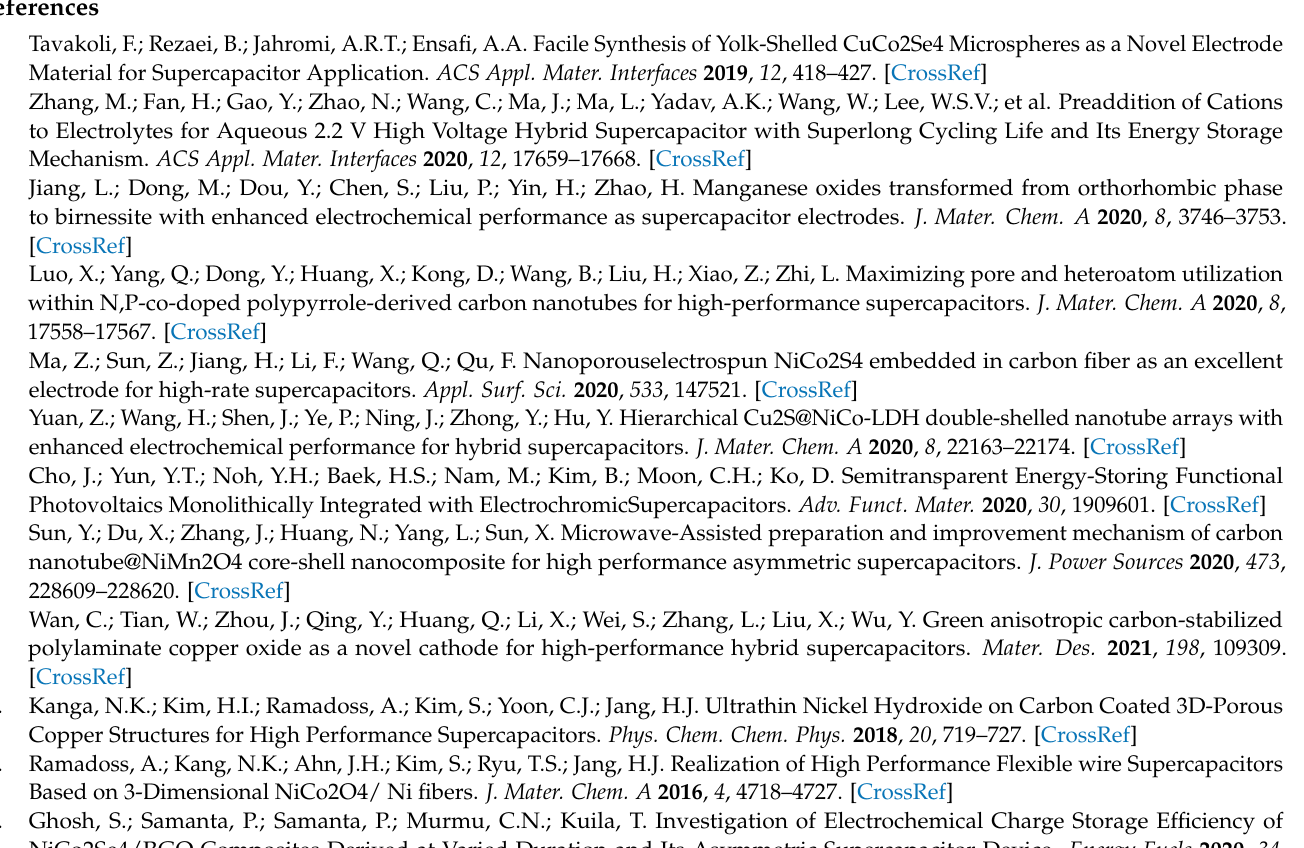
Figure S2: (a,b) IFFT pattern of (A)and (B)regions, respectively of Figure 2a. Figure S3: FTIR spectra of NSC, NCuSC, and NCoSC electrodes. Figure S4: (a,b) CV curves of NSC and NCuSC electrodes at different scan rates, respectively. (c) Comparable discharge plots of NSC, NCuSC and NCoSC electrodes at 3 A g − 1 current density (d,e) GCD plots of NSC and NCuSC electrodes, respectively at different current density. Figure S5: (a–c) Z-View fitted EIS spectra of NSC, NCuSC, and NCoSC electrodes and (d) EIS spectra of NSC, NCuSC, and NCoSC at high frequency range. Figure S6: (a,b) CV and GCD plots of TRGO at different scan rates and current densities, respectively. (c) CV curves of positive, negative, and fabricated device in their respective potential window at constant 30 mV s − 1 scan rate. Table S1: Comparison of supercapacitor properties of some nickel-based hybrid supercapacitor